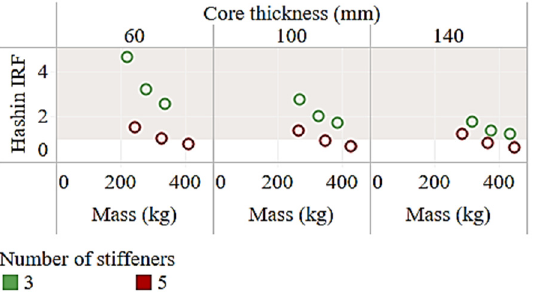
Figure 17. Influence of core thickness on the no. of stiffeners in the assessment of Hashin criteria. Red represents a 3 stiffener configuration and green represents a 5 stiffener configuration.